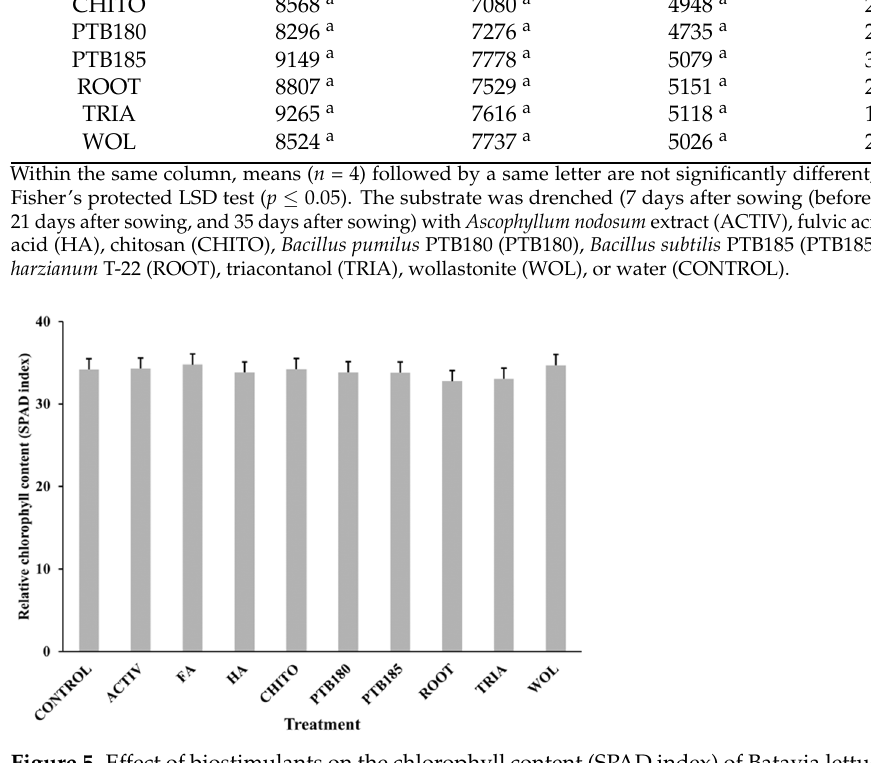
Figure 5. Effect of biostimulants on the chlorophyll content (SPAD index) of Batavia lettuce. Substrate was drenched (7 days after sowing (before water stress), 21 days after sowing, and 35 days after sowing) with Ascophyllum nodosum extract (ACTIV), fulvic acid (FA), humic acid (HA), chitosan (CHITO), Bacillus pumilus PTB180 (PTB180), Bacillus subtilis PTB185 (PTB185), Trichoderma harzianum T-22 (ROOT), triacontanol (TRIA), wollastonite (WOL), or water (CONTROL). The means ( n = 32; ± standard error ) are not significantly different ( p ≤ 0.05).